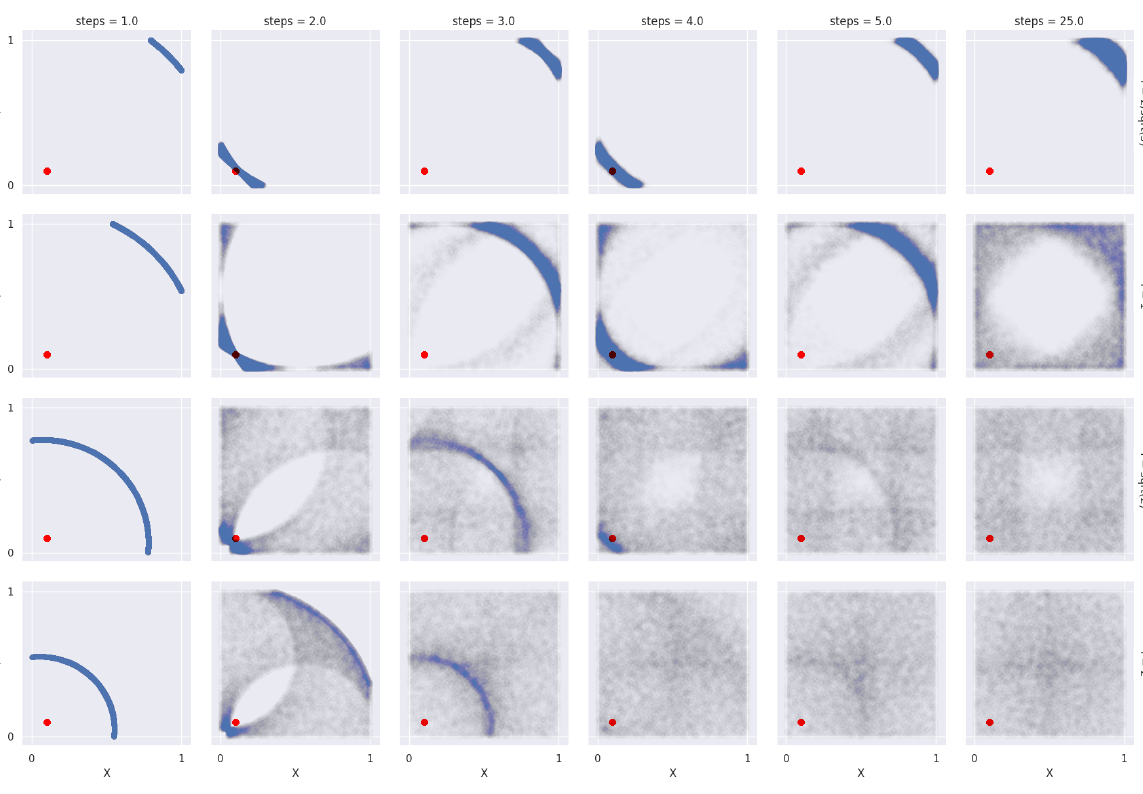
√ (cid:112) 5 , 1 , (2) , 2). Each distribution